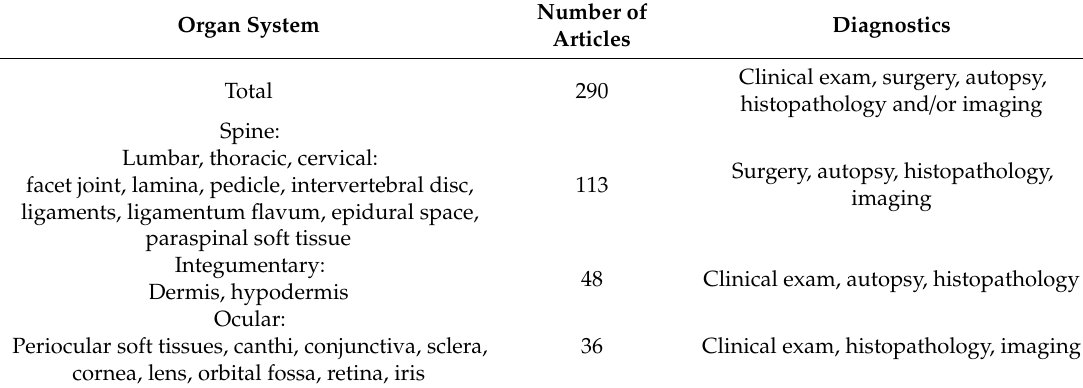
Table 1. Sites of extraarticular urate